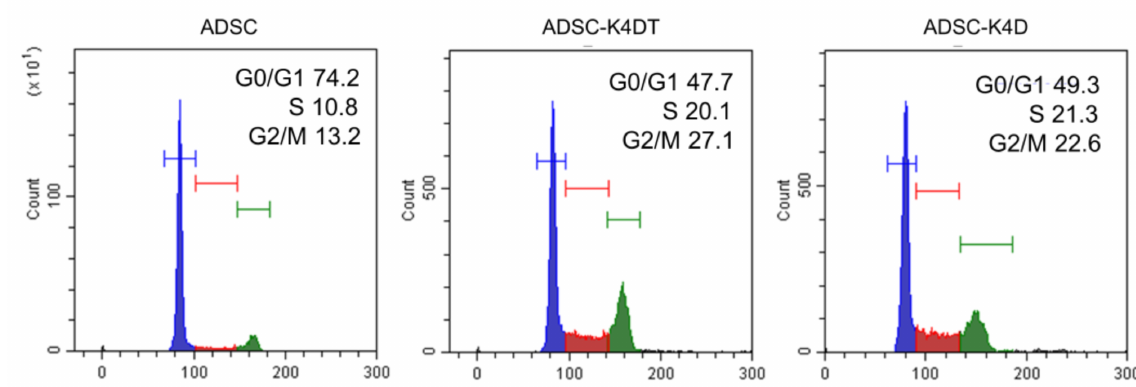
Figure 2. Cell cycle analysis of the primary ADSCs, and the ADSC-K4DT and ADSC-K4D